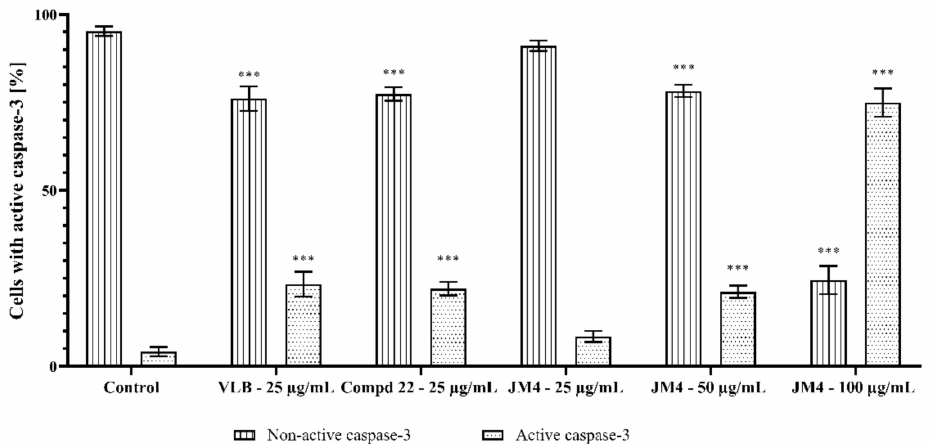
Figure 12. Percentage of C32 melanoma cells with nonactive and active caspase-3 after 24 h incubation with JM4 (25, 50, 100 µ g/mL), 22 (25 µ g/mL) and vinblastine sulfate (VLB) (25 µ g/mL). Mean percentage values from three independent experiments ( n = 3) done in duplicate are presented. *** p < 0.001 versus control